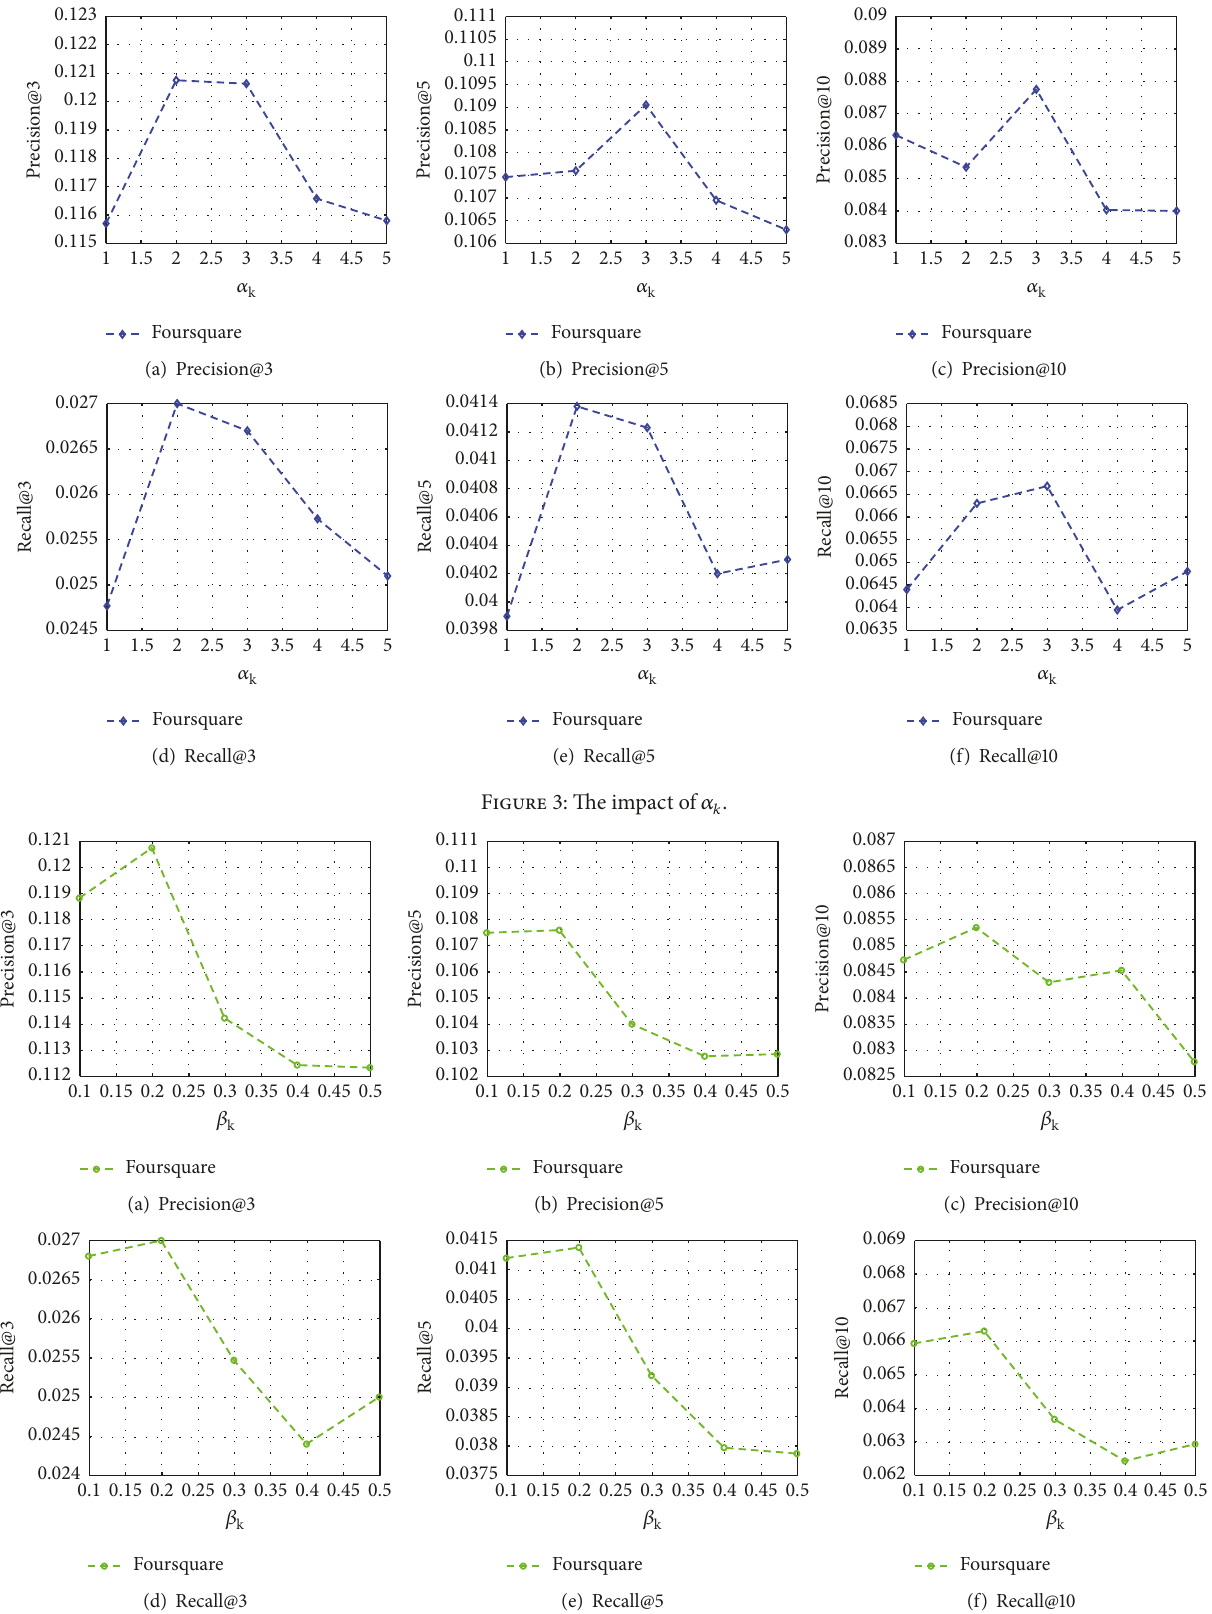
Figure 3: The impact of 𝛼 𝑘 .